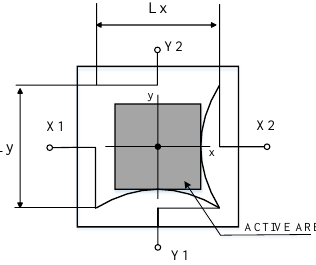
Figure 3. The active area chart of pin-cushion type PSD.